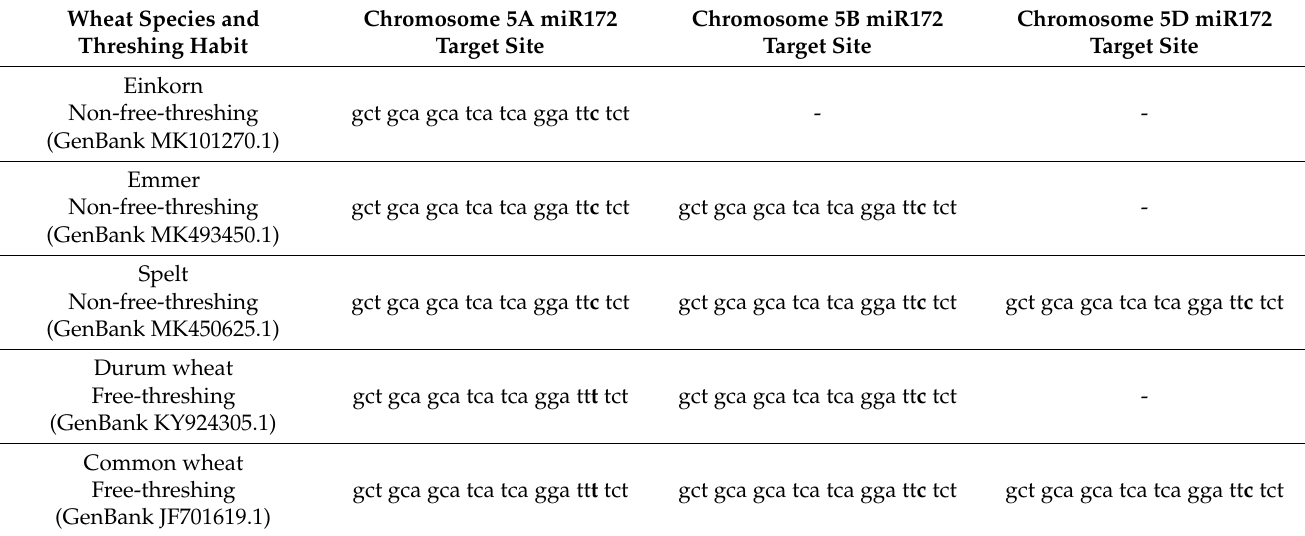
Figure 1. Polynomial curves reporting the theoretical relationships among FAM/VIC ratios and hulless/hulled wheats. The red curve refers to the case of durum wheat mixed with hulled wheats of any ploidy level; the blue curve refers to the case of common wheat mixed with hulled wheats of any ploidy level; the grey curve refers to a “mean situation” in which a 50:50 mixture of durum and common wheat is mixed with hulled wheats of any ploidy level. Table 3. Sequence variation at the miR172 target site in different homoeologs and in wheat species different in ploidy level and grain